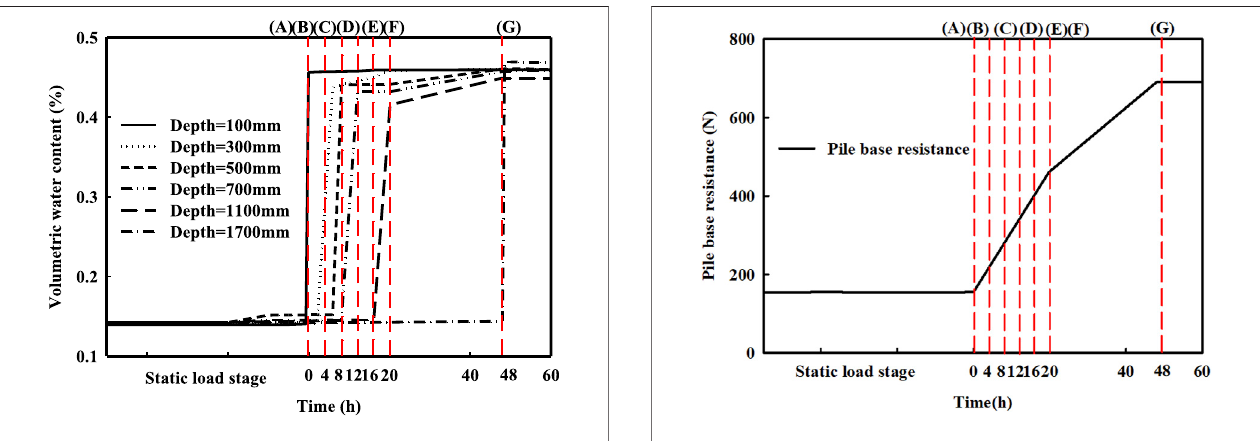
FIGURE 13 | Variations of pile base pressure with the time of PITC.